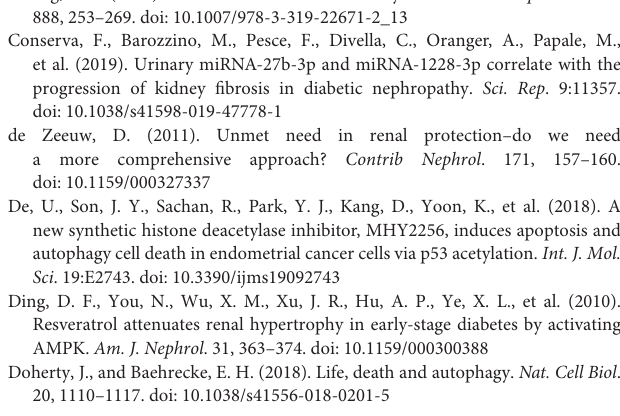
Supplementary Figure 1 | Schematic representation of proposed mechanism of miR-150-5p on diabetic